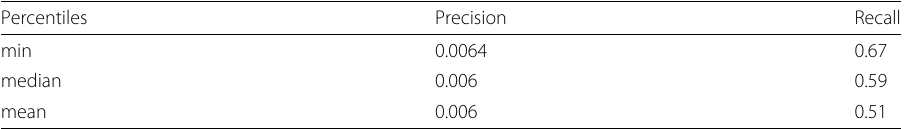
Table 8 Identified proteins reachability from the private egocentric metabolites networks according the combined score percentiles Percentiles Precision min median